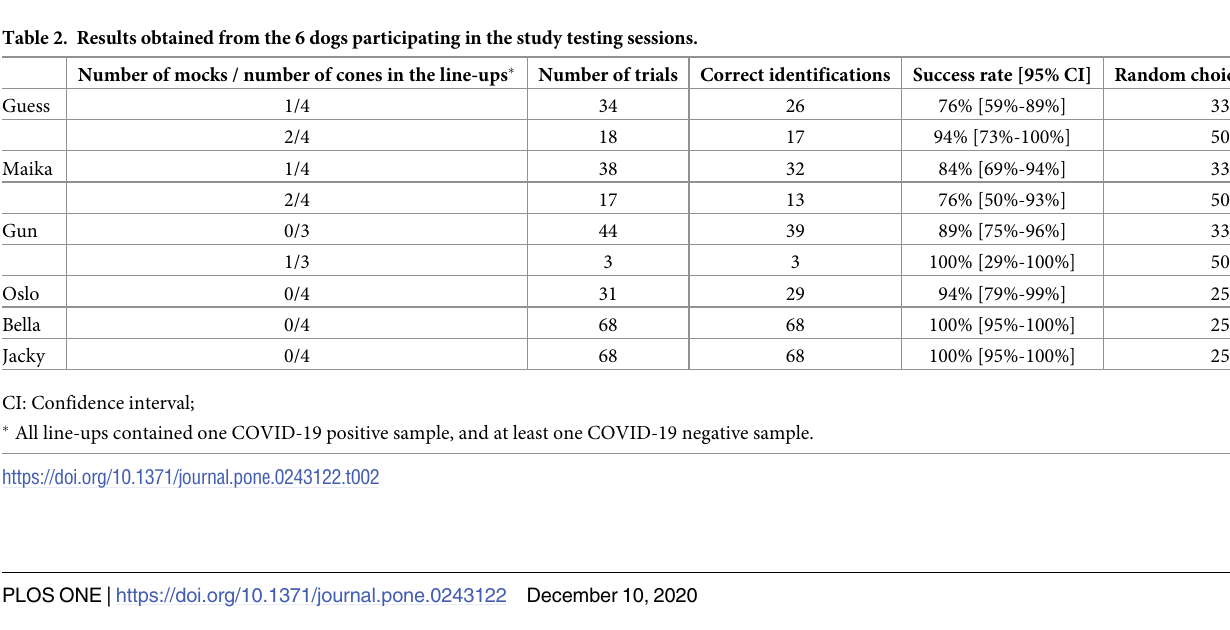
Table 2. Results obtained from the 6 dogs participating in the study testing sessions. Number of mocks / number of cones in the line-ups � Number of trials Correct identifications Success rate [95% CI] Random choice proportion Guess